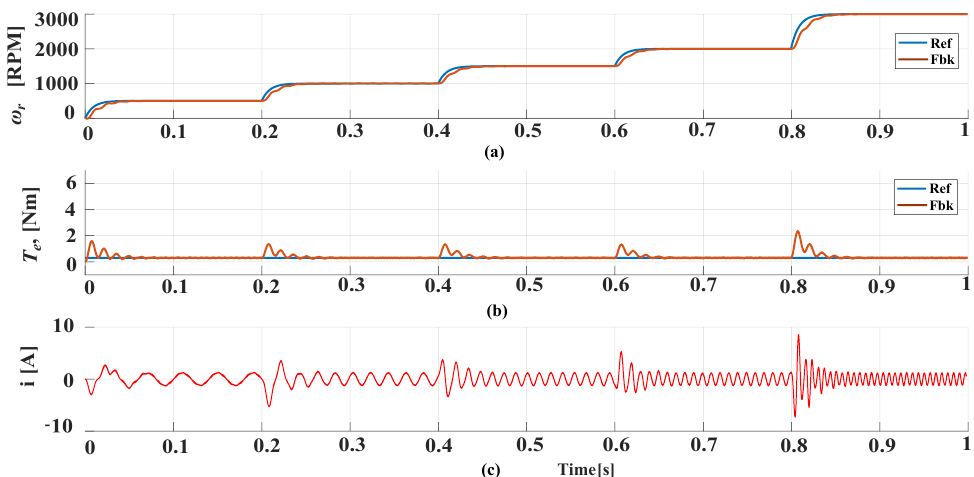
Figure 12. Simulation result of the 9-level inverter when the speed is varied: ( a ) Speed reference and its feedback. ( b ) Torque reference and feedback. ( c ) Phase current.